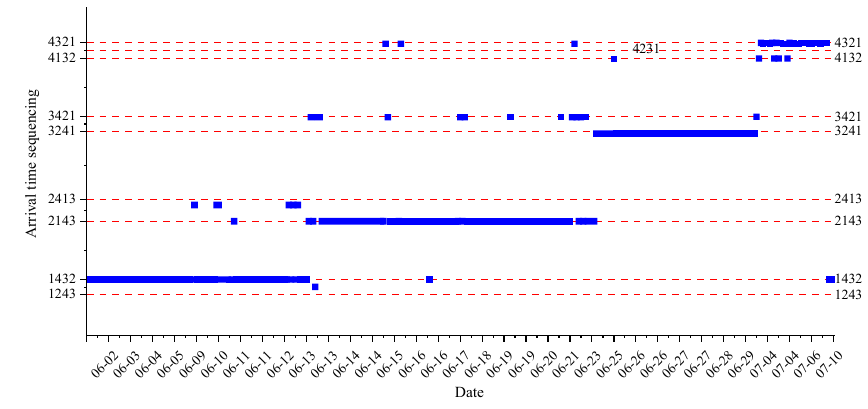
Figure 5. Arrival time results in the four different periods.